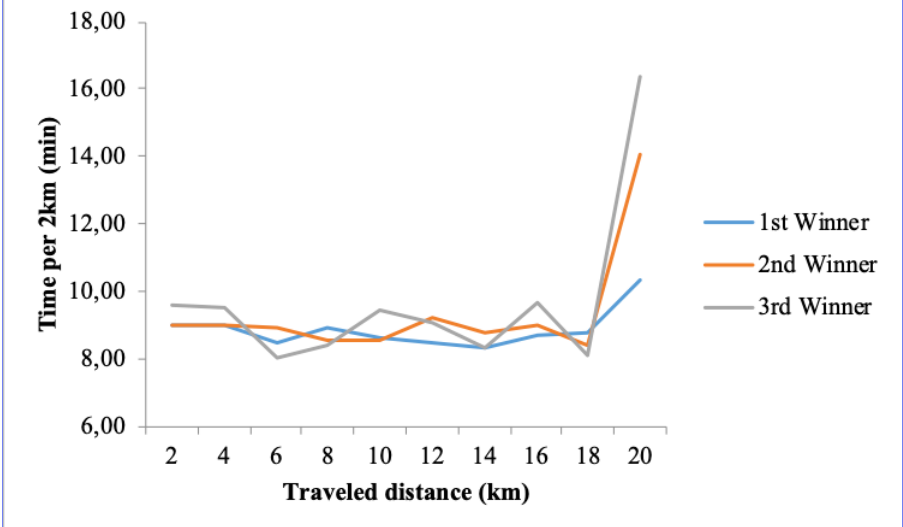
Figure 2 . The individual times per 2km of the winners in the 20km women’s race